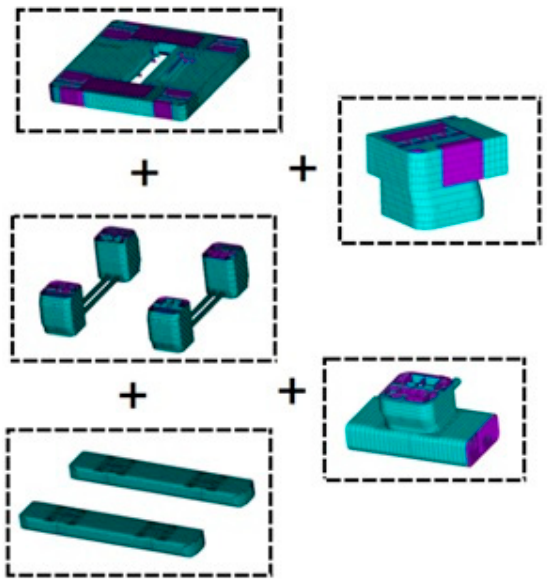
Figure 13. System reliability model of semi-submersible